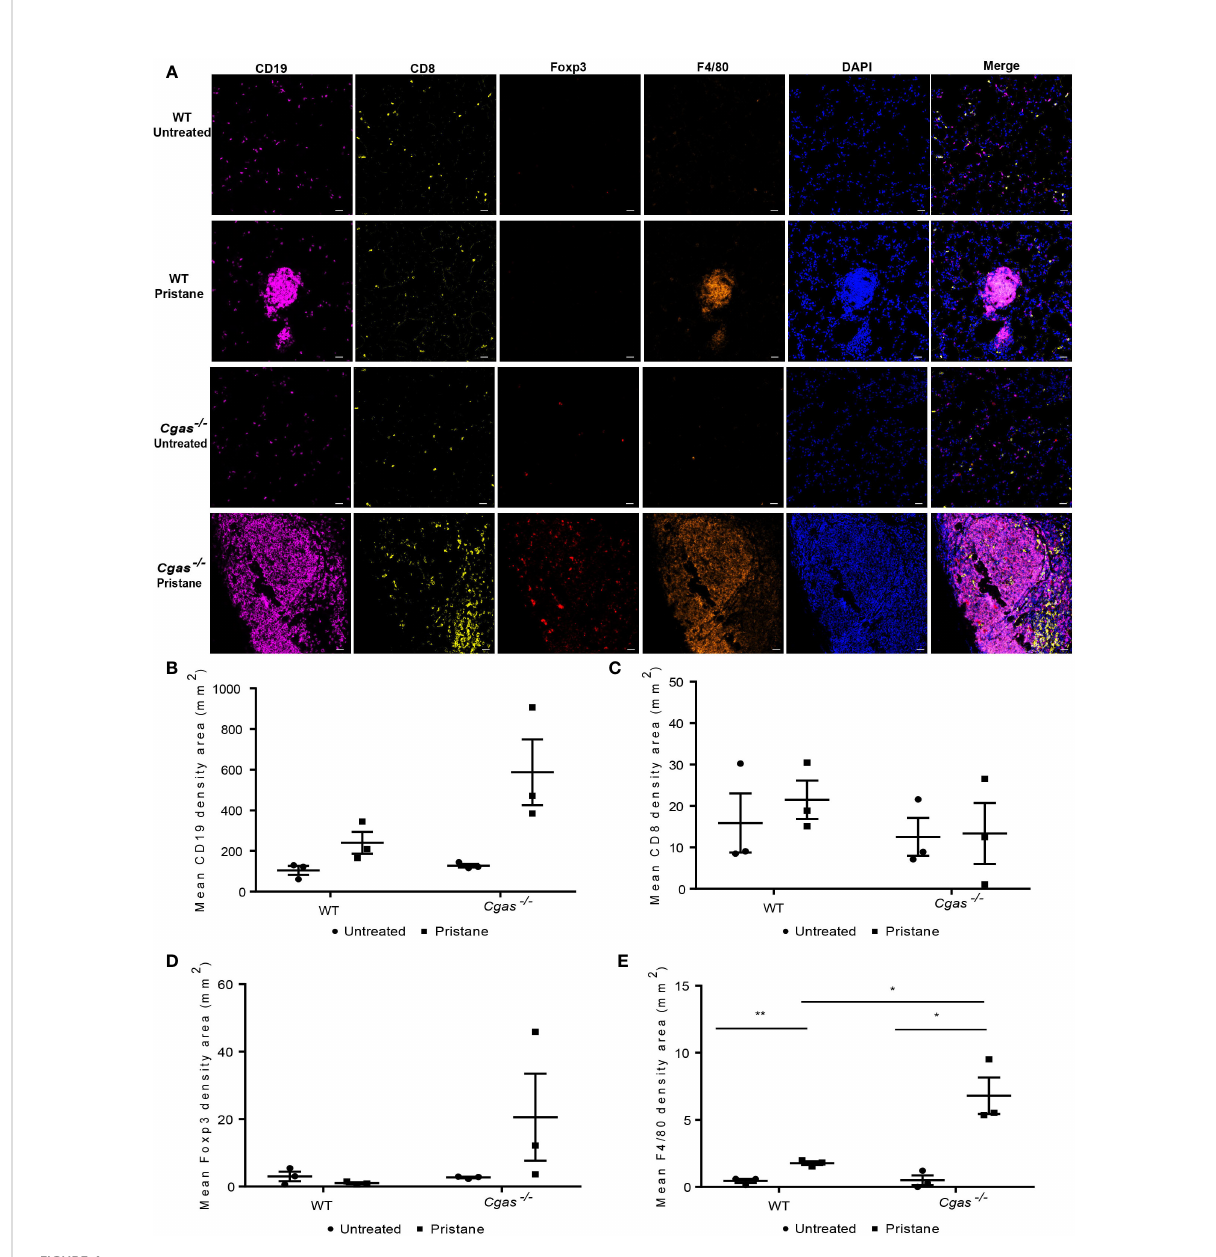
FIGURE 4 cGAS de fi ciency promotes the in fi ltration of macrophages in the lung. (A) Multiplex immuno fl uorescence staining of the lung from WT and Cgas -/- mice at 8 months after pristane injection shows CD19 (magenta), CD8 (yellow), Foxp3 (red), F4/80 (orange), and DAPI (blue). Data represent 3 mice per group (scale bar, 500 µm). (B – E) The mean density area of CD19 (B) , CD8 (C) , Foxp3 (D) , and F4/80 (E) (n = 3 per group). Data are shown as the mean ± SEM. *p < 0.05, **p <